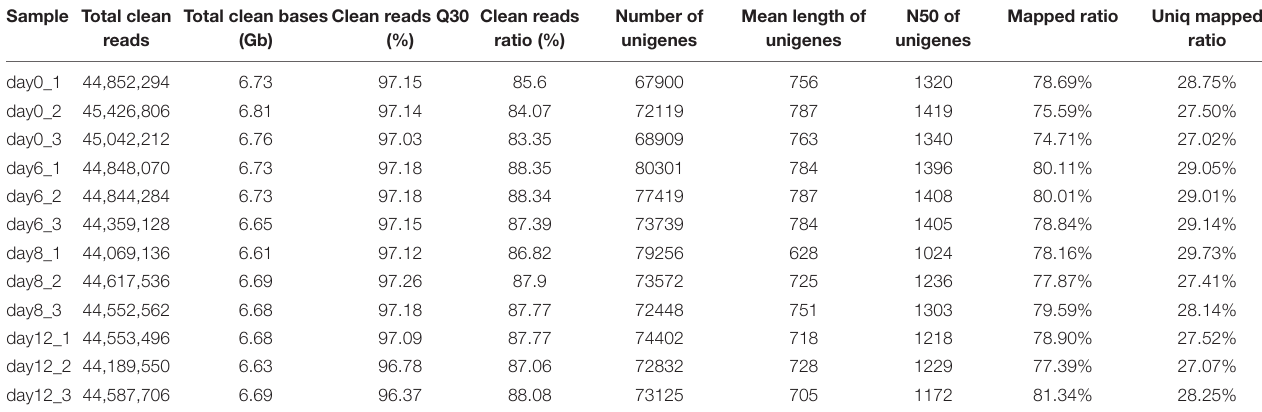
TABLE 1 | The transcriptome information of data assembly and quality for 12 samples of pearl sac. Sample Total clean Total clean bases Clean reads Q30 Clean reads Number of Mean length of N50 of Mapped ratio Uniq mapped reads (Gb) (%) ratio (%) unigenes unigenes unigenes